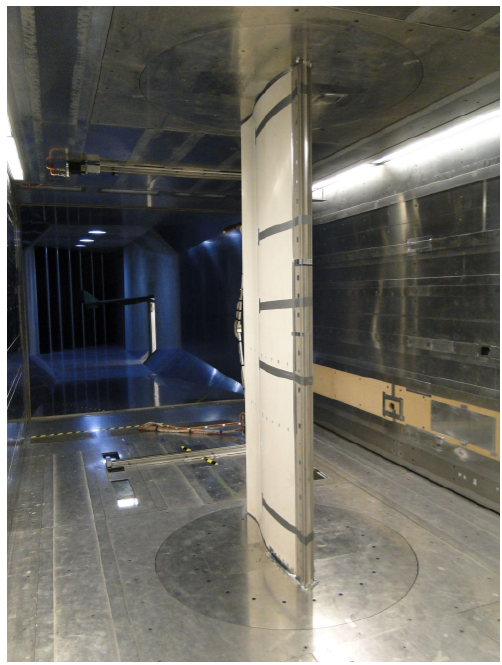
Figure 8. Experimental setup of an airfoil with ice profile-1 in the German-Dutch low wind speed, open section wind